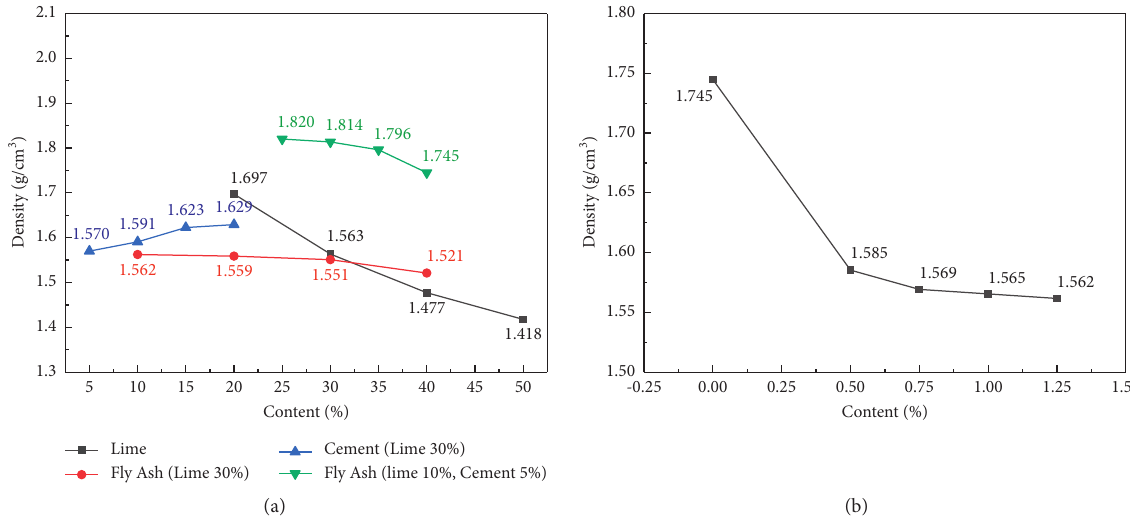
Figure 9: The influence of different content of lime, fly ash, cement, and polyvinyl alcohol (lime 10%, cement 5%, and fly ash 40%) on sample density.